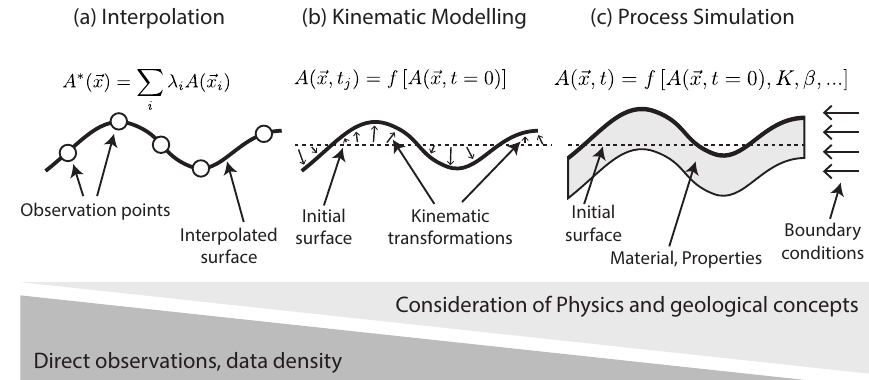
Figure 1. Conceptual difference of modelling approaches: (a) interpolation, (b) dynamic process simulations, (c) kinematic models (modified from Jessell and Valenta,